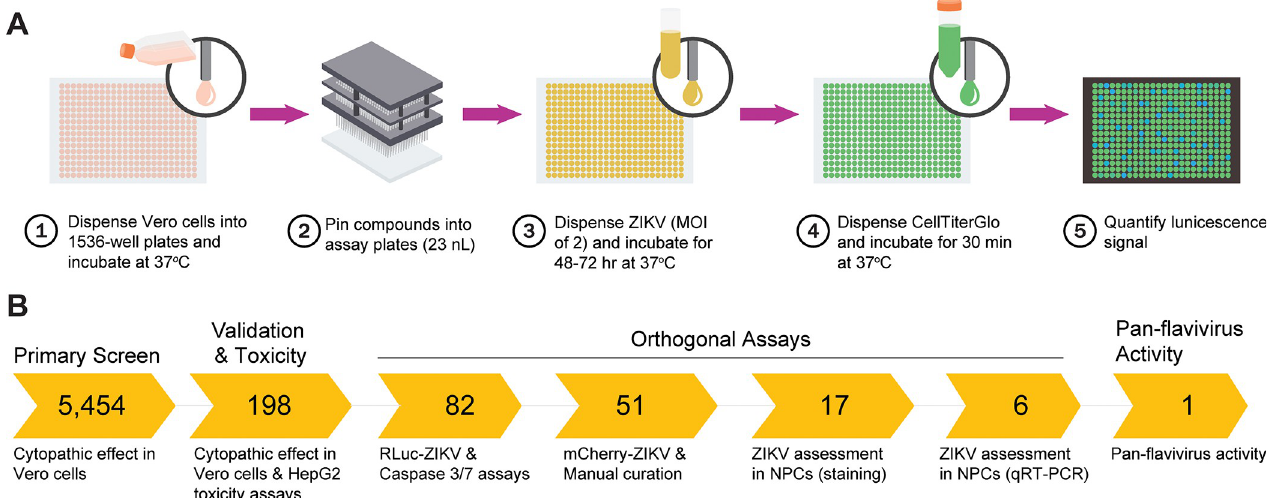
Fig 1. Quantitative high-throughput screening for anti-ZIKV compounds. (A) Schematic representation of the quantitative high-throughput (qHTS) screening method for Zika antiviral compounds as assessed using a cytopathic effect (CPE) readout. ZIKV, Zika virus; MOI, multiplicity of infection. (B) Overview of the compound triaging workflow, where the primary CPE assay was followed by rescreening validation as well as assessing toxicity against HepG2 cells. Compounds were then screened using a recombinant Renilla-ZIKV as well as a Caspase 3/7 induction assay, and a subsequent orthogonal assay employing a recombinant mCherry-ZIKV. Validated compounds were then screened for activity against other flaviviruses, including West Nile Virus, Yellow Fever Virus and Dengue Virus.